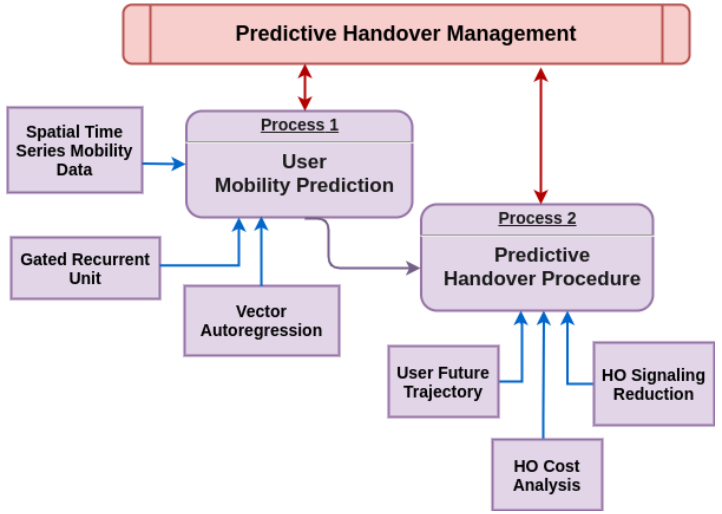
Figure 1. The proposed handover management